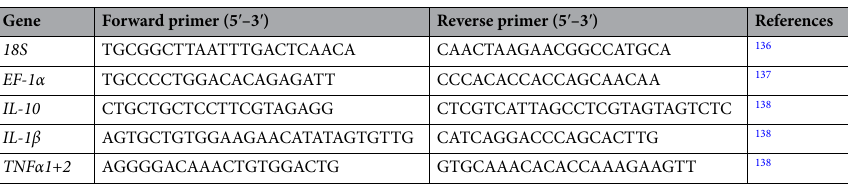
Table 2. Primer sequences and corresponding